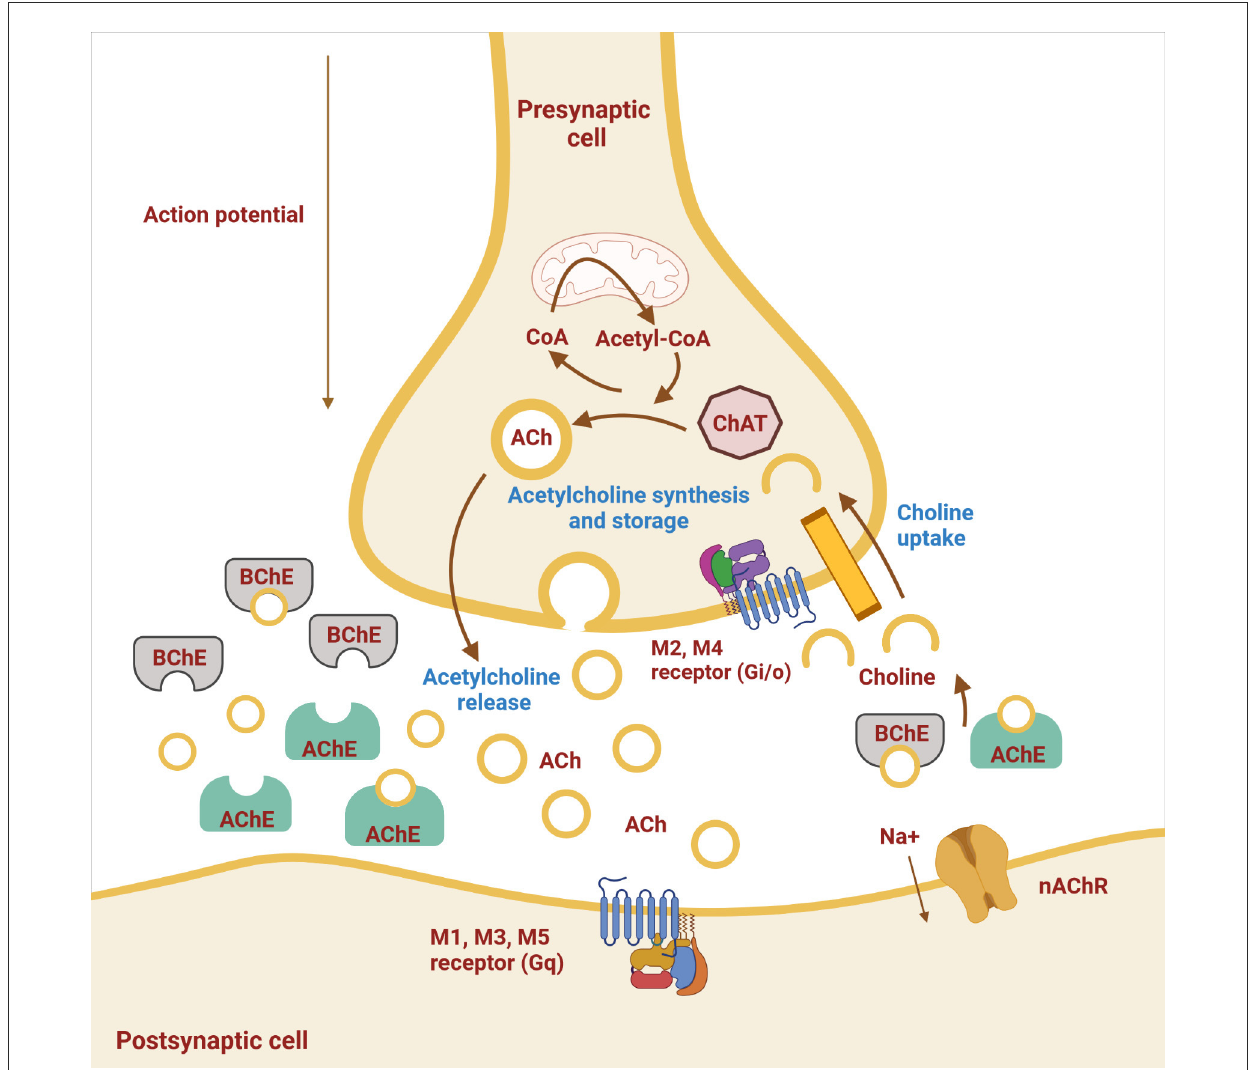
FIGURE1 Schematic representation of a cholinergic neuron. Shown are the cell membrane of the pre- and postsynaptic neuron with synaptic cleft and ongoing processes. Synthesis of acetylcholine (ACh) by choline acetyltransferase (ChAT) from choline and acetyl-CoA, storage, and release occur in the presynaptic neuron, whereas hydrolysis of ACh by acetylcholinesterase (AChE) and butyrylcholinesterase (BChE) occurs in the synaptic cleft. The two types of cholinergic receptors in the postsynaptic membrane are muscarinic (M1–M5) and nicotinic (nAChR) receptors (Created with